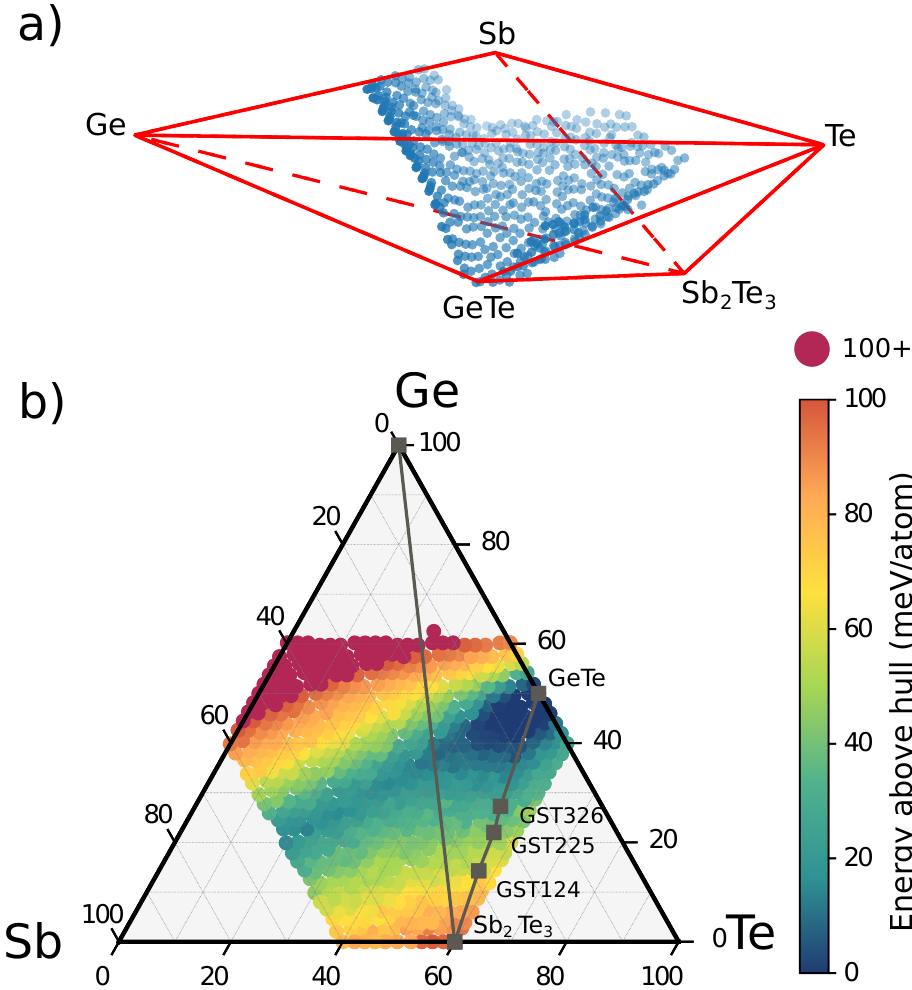
Figure 2. ( a ) Convex hull in the Ge-Sb-Te phase diagram. The energy of the elements in their standard state is set to zero. The figure shows a simplified convex hull in which the stable pseudobinary GeTe-Sb 2 Te 3 compounds and the stable Sb n Te compounds have been brought on the GeTe-Sb 2 Te 3 and Sb-Sb 2 Te 3 tie-lines (see text). The formation free energy of the different alloys is also shown by blue points only for compositions with a negative formation free energy (see Figure 1). ( b ) Map of the distance of the formation free energy (meV/atom) of the cubic alloys from the convex hull. The shorter the distance the higher is the degree of metastability of the alloy. The GeTe-Sb 2 Te 3 and Ge-Sb 2 Te 3 tie-lines are also shown in panel ( b ) along with the points corresponding to some stable (GeTe) n (Sb 2 Te 3 ) m pseudobinary